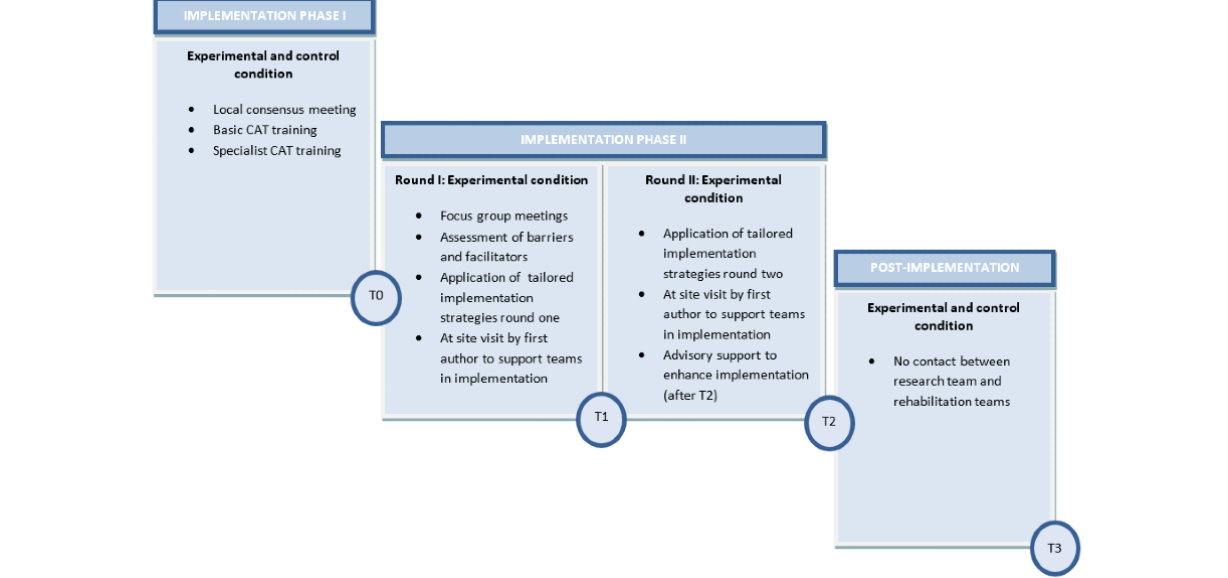
Figure 1. Implementation program. CAT: Cognitive Adaptation